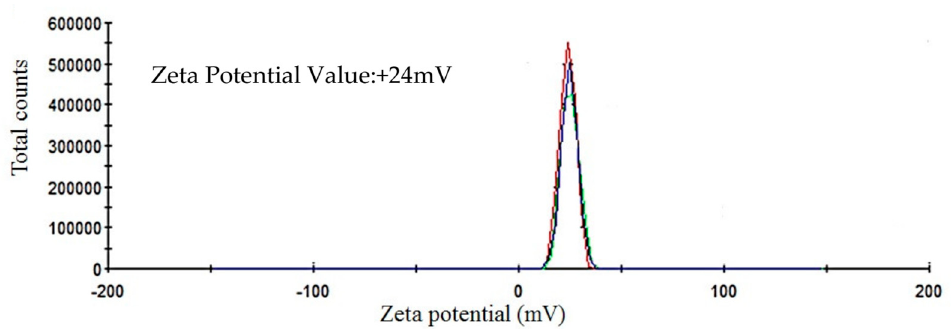
Figure 5. Showing zeta potential value of extracellular IONPs.